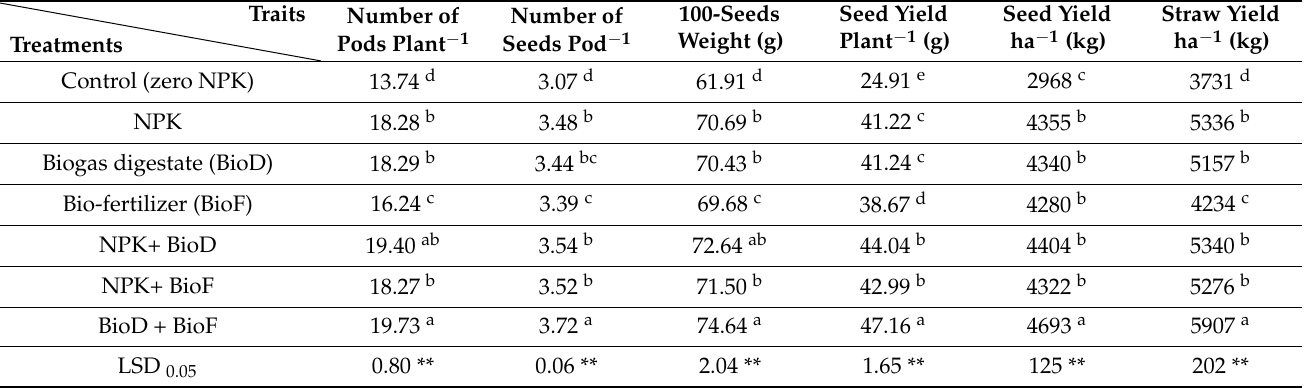
Table 2. Effect of synthetic, organic, and bio-fertilizers on yield and yield components of faba